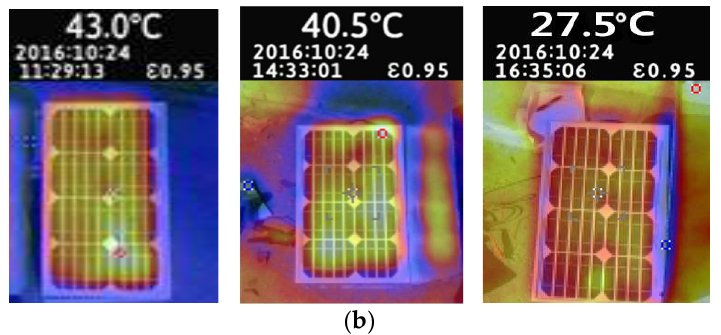
Figure 13. Studying effect on temperature of PV module ( a ) Without BRS; ( b ) Al foil BRS.